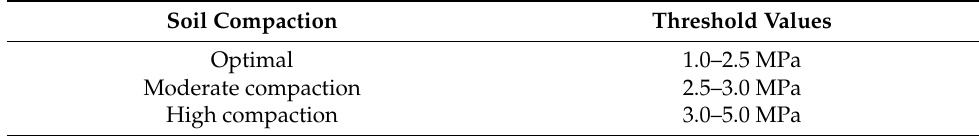
Table 2. Threshold values of soil compaction